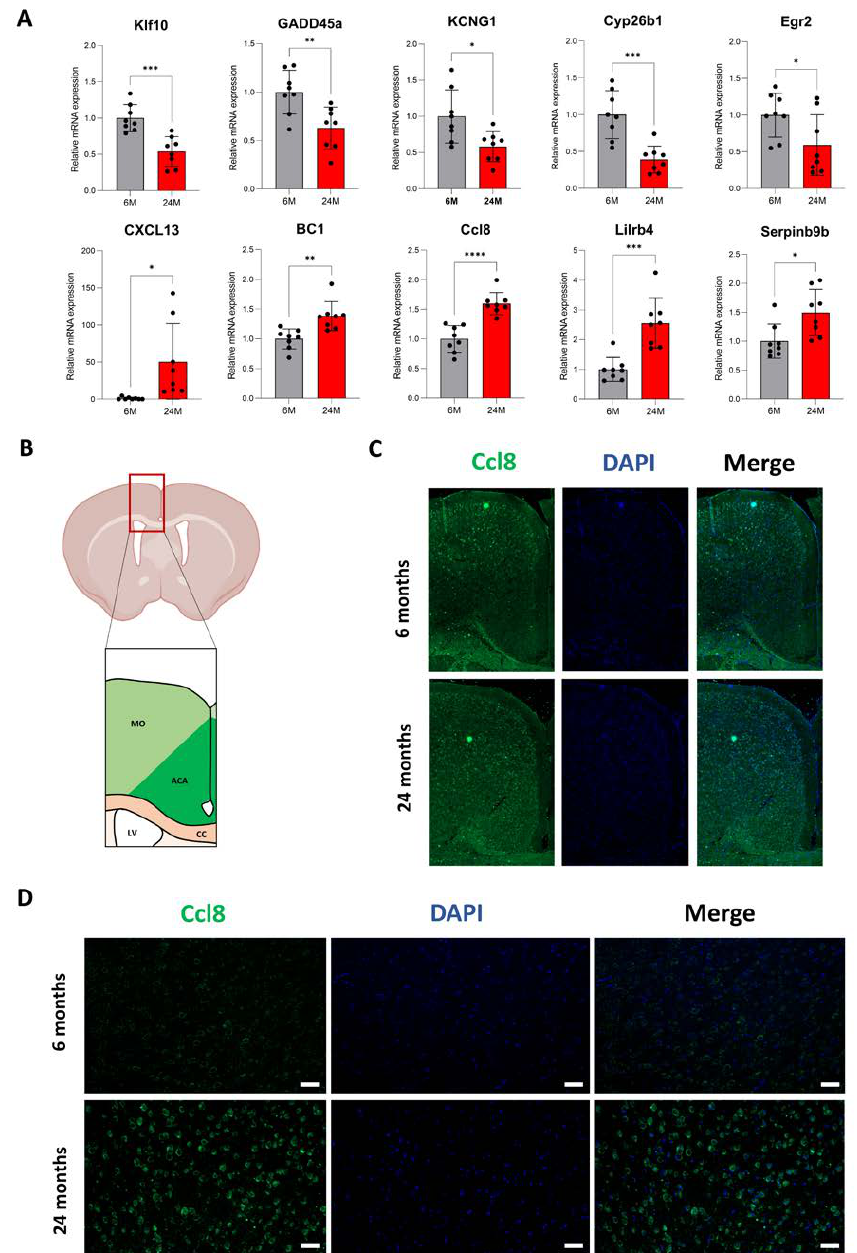
Figure 3. Validation of candidate genes differentially expressed in the aging cortex. ( A ) mRNA levels of Klf10, GADD45a, KCNG1, Cyp26b1, Egr2, CXCL13, BC1, Ccl8, Lilrb4b and Serpina9b were measured in cortices of 6-month-old (grey) and 24-month-old (red) mice by quantitative PCR and